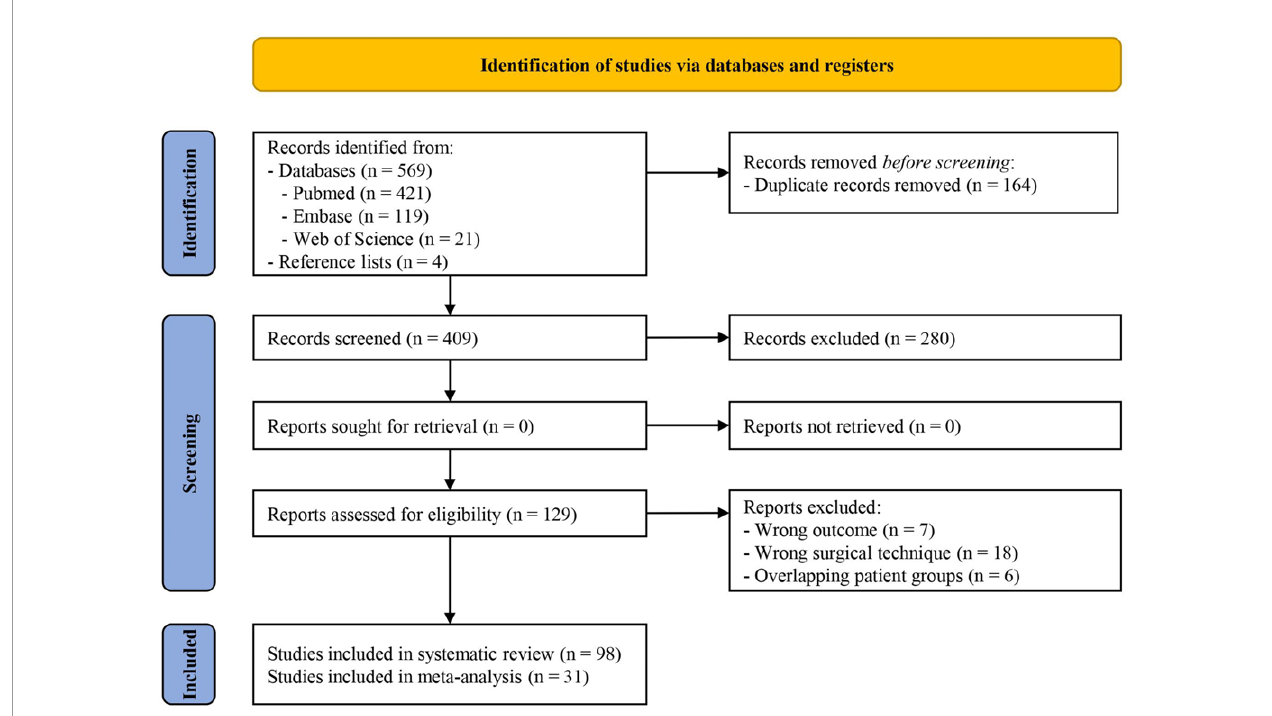
FIGURE 2 | Flowchart of study selection using PRISMA 2020 fl ow